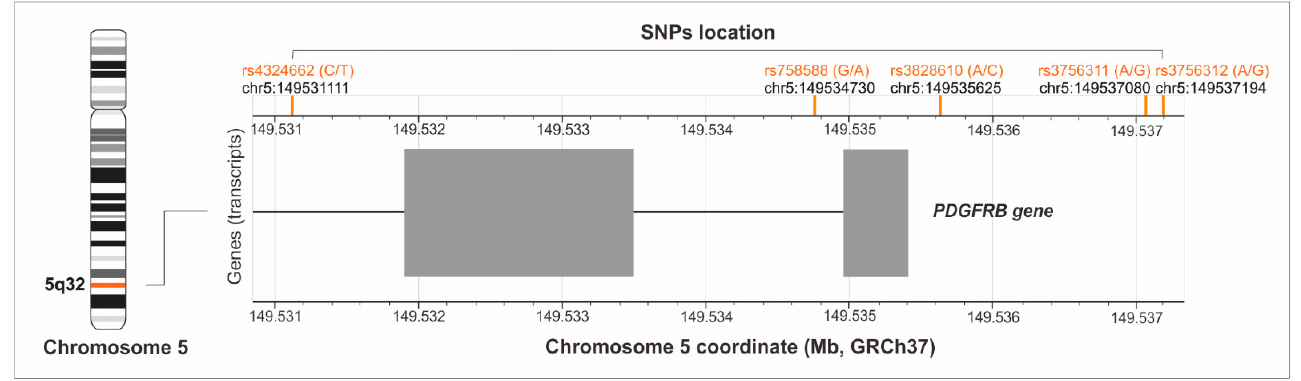
Figure 2. Location of the studied polymorphisms on chromosome 5 (the figure was created with the use of LDmatrix Tool [14]).